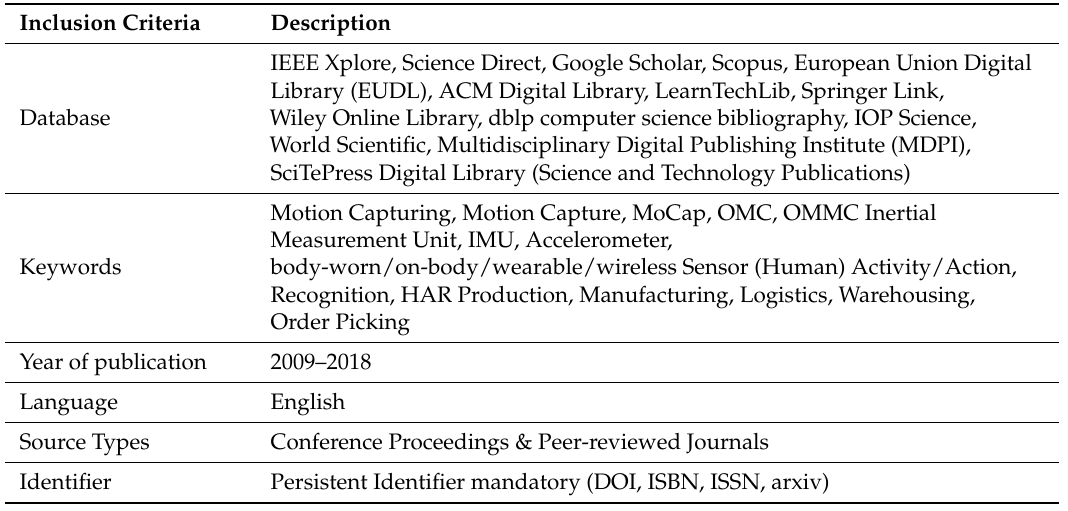
Table 2. Inclusion Criteria for original contributions and related